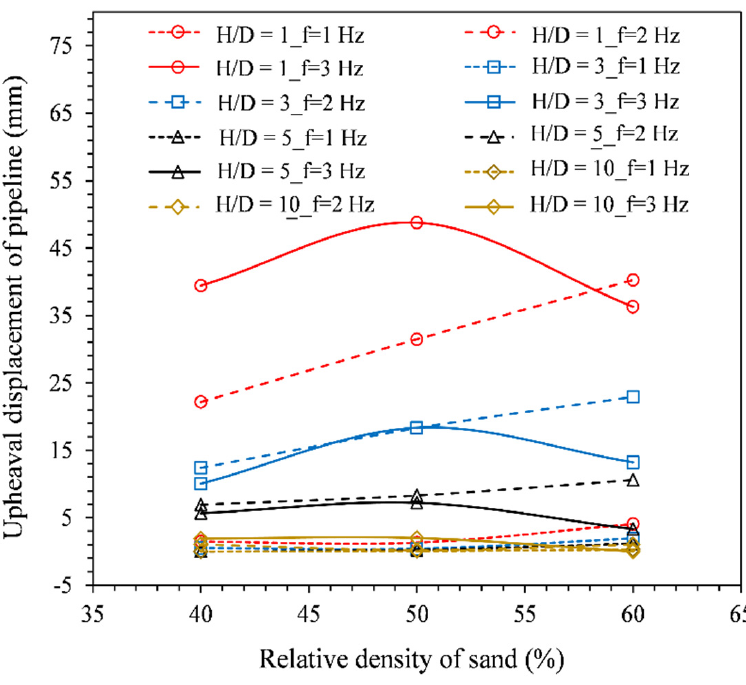
Figure 10. Variation of the upheaval displacement of the pipeline with the relative density of the sand.